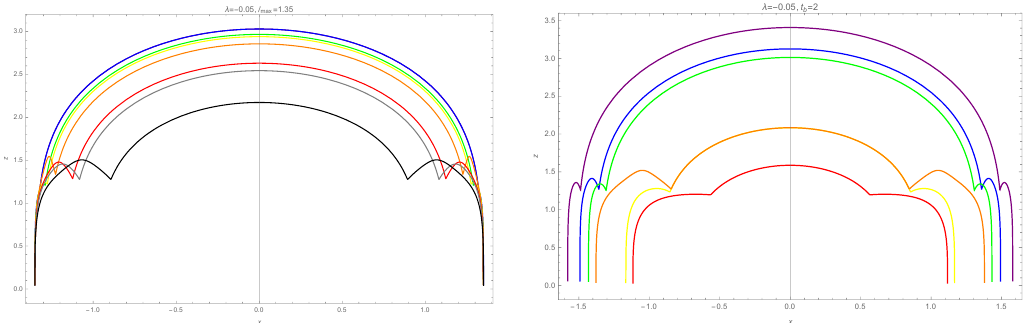
Figure 9 . Left panel: x vs z pro(cid:12)le of representative geodesics with (cid:21) GB = (cid:0) 0 : 05 and (cid:12)xed ‘ = 1 : 35. Right panel: x vs z pro(cid:12)le of representative geodesics with (cid:21) = (cid:0) 0 : 05 and (cid:12)xed t b = 2.